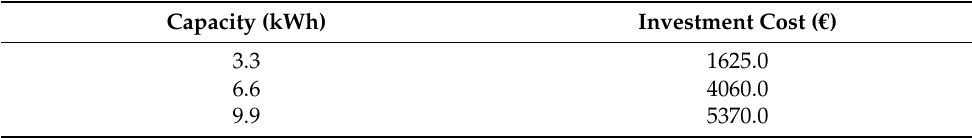
Table 9. Investment costs in three different battery packs according to [41].